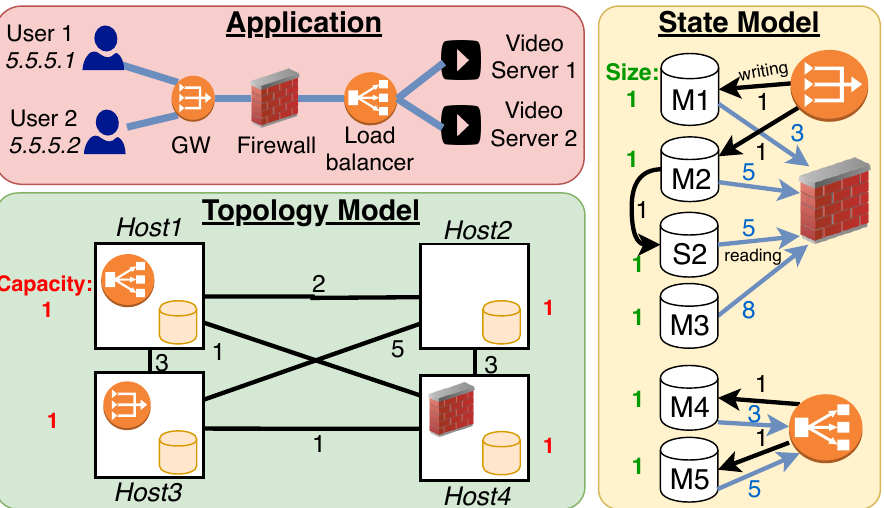
Figure 2. An example of a server cluster ( lower left side ), a cloud-based application ( upper left side ), and the corresponding State Access Descriptor including all the required state instances (masters: M1–M5, slave: S2) to externalize ( right side